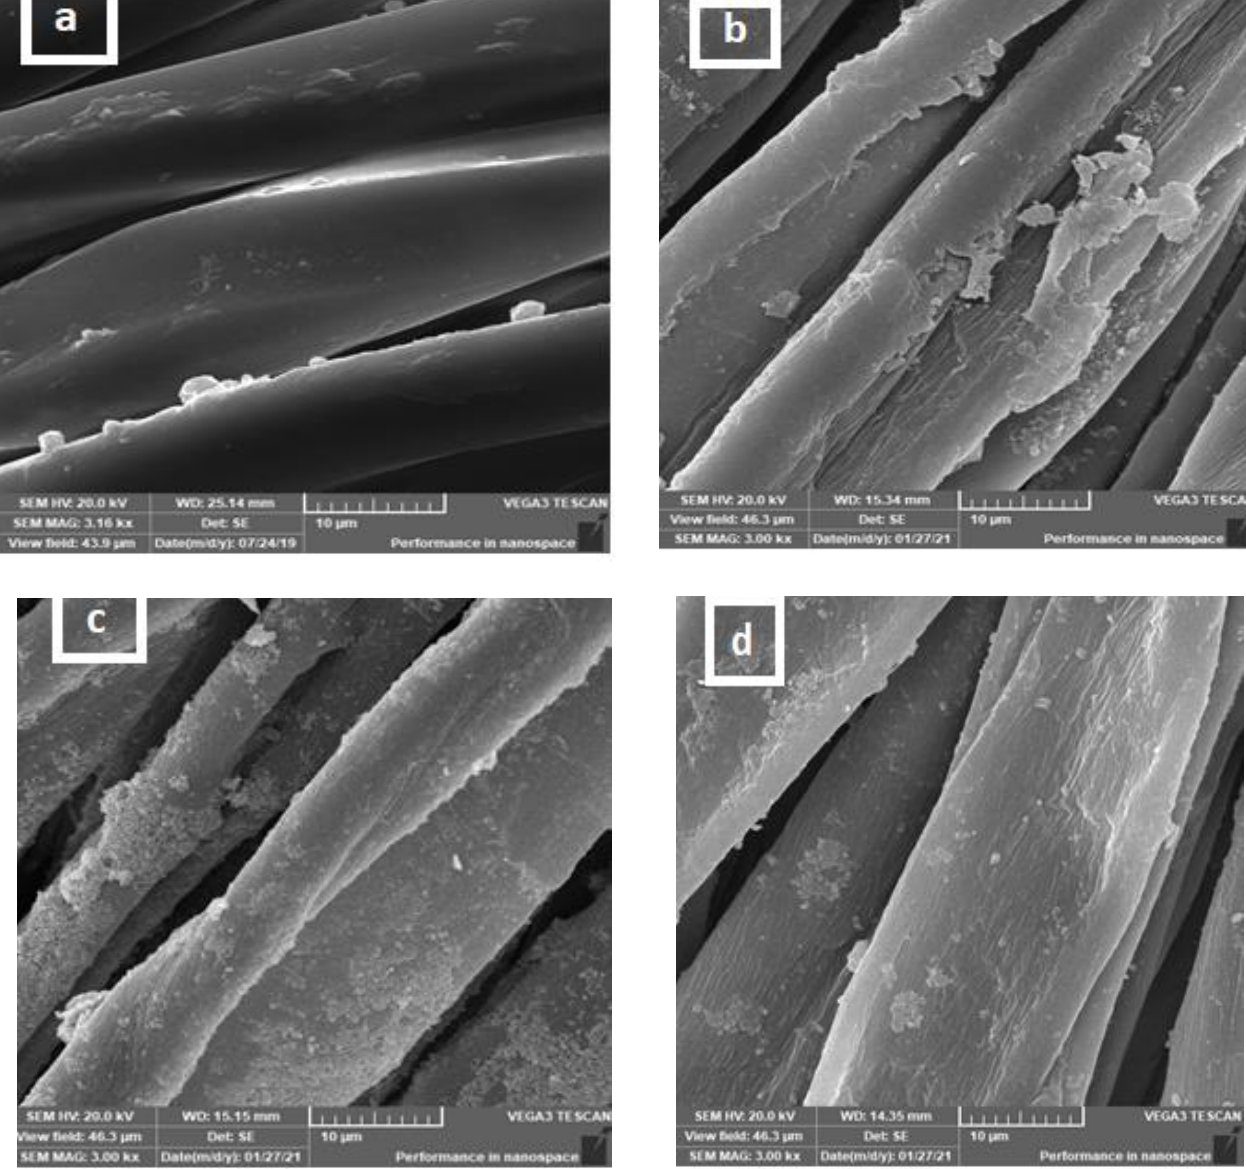
Figure 3. SEM images of control cotton fabric ( a ), curcumin/TiO 2 –citric-modified cotton fabric ( b ), curcumin/TiO 2 –Quat 188-modified cotton fabric ( c ), curcumin/TiO 2 –GPTMS-modified cotton fabric ( d